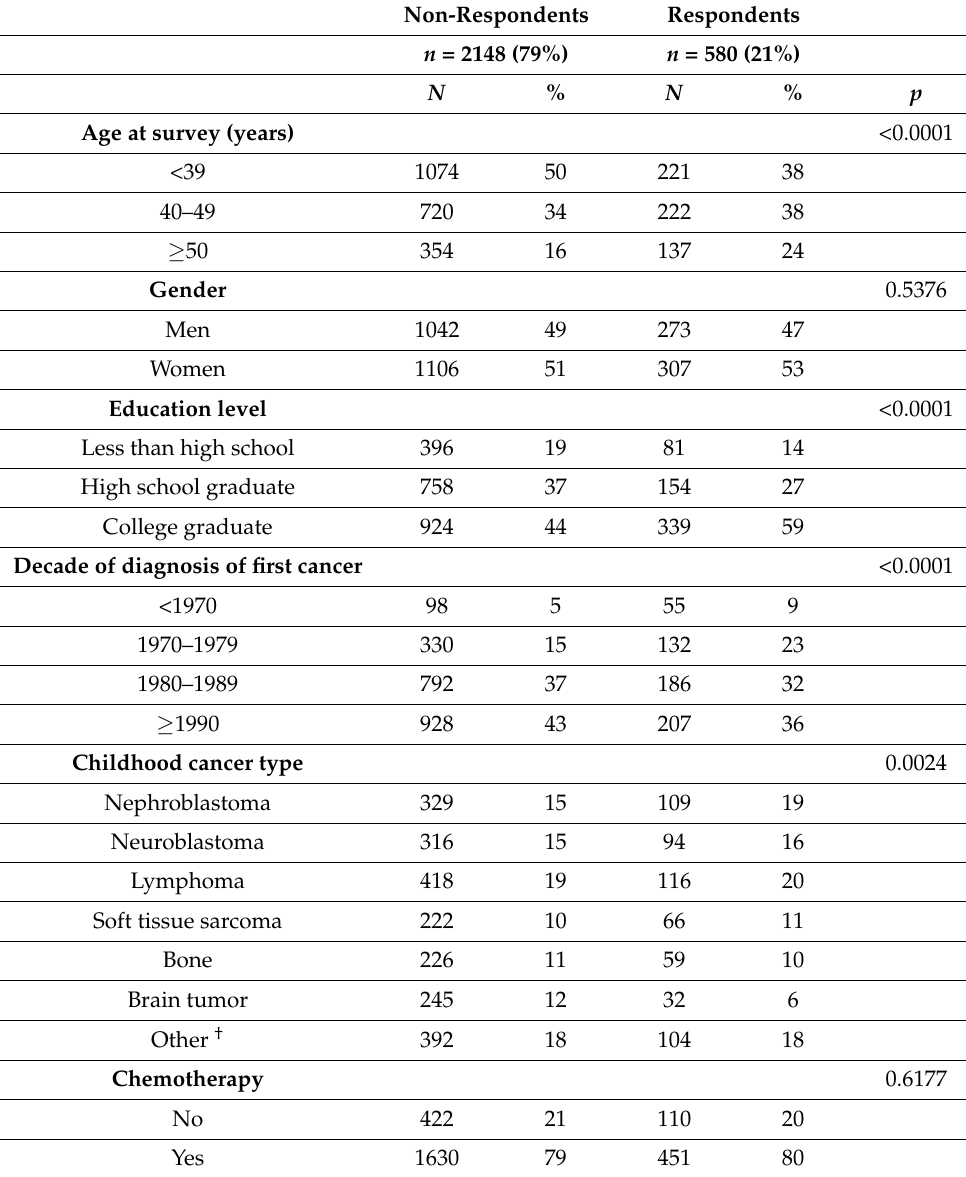
Table 1. Comparison of demographic, socioeconomic, and clinical characteristics between respon- dents and non-respondents to the